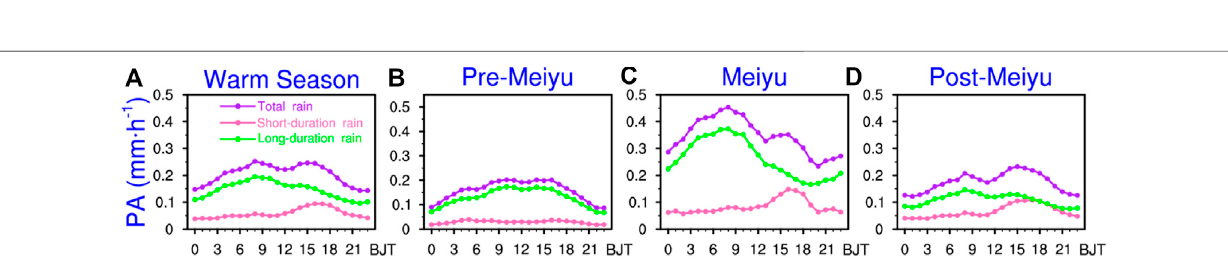
Frontiers in Earth Science |